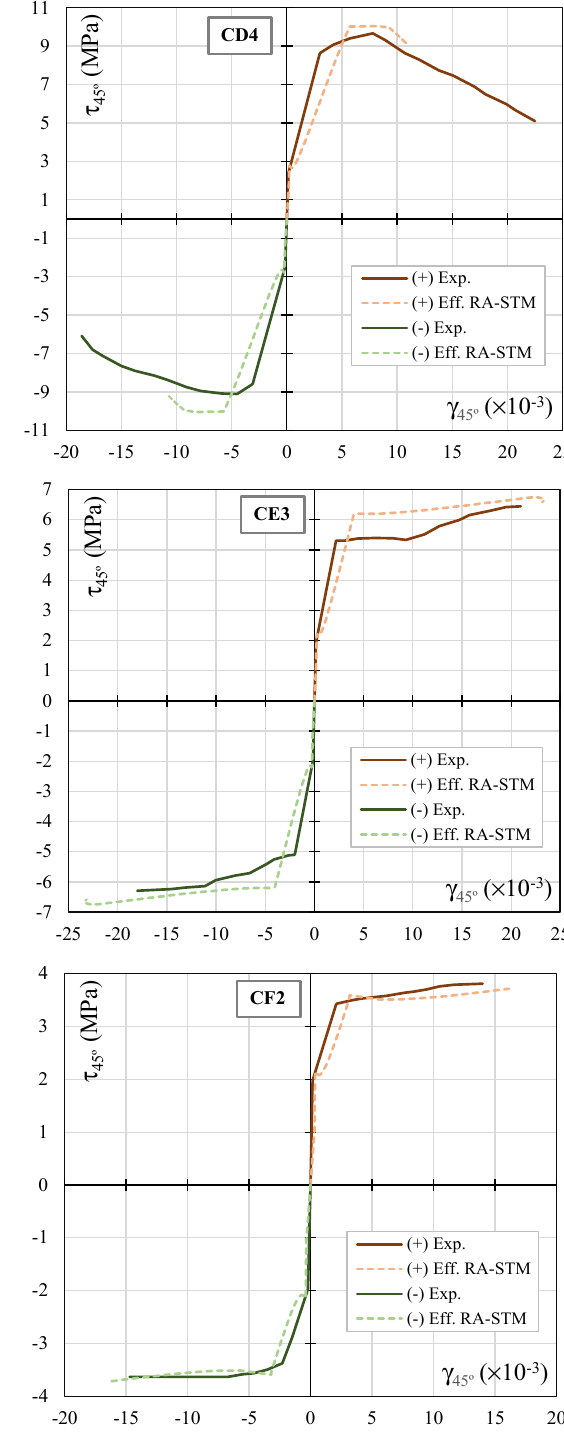
Figure 6. Envelope